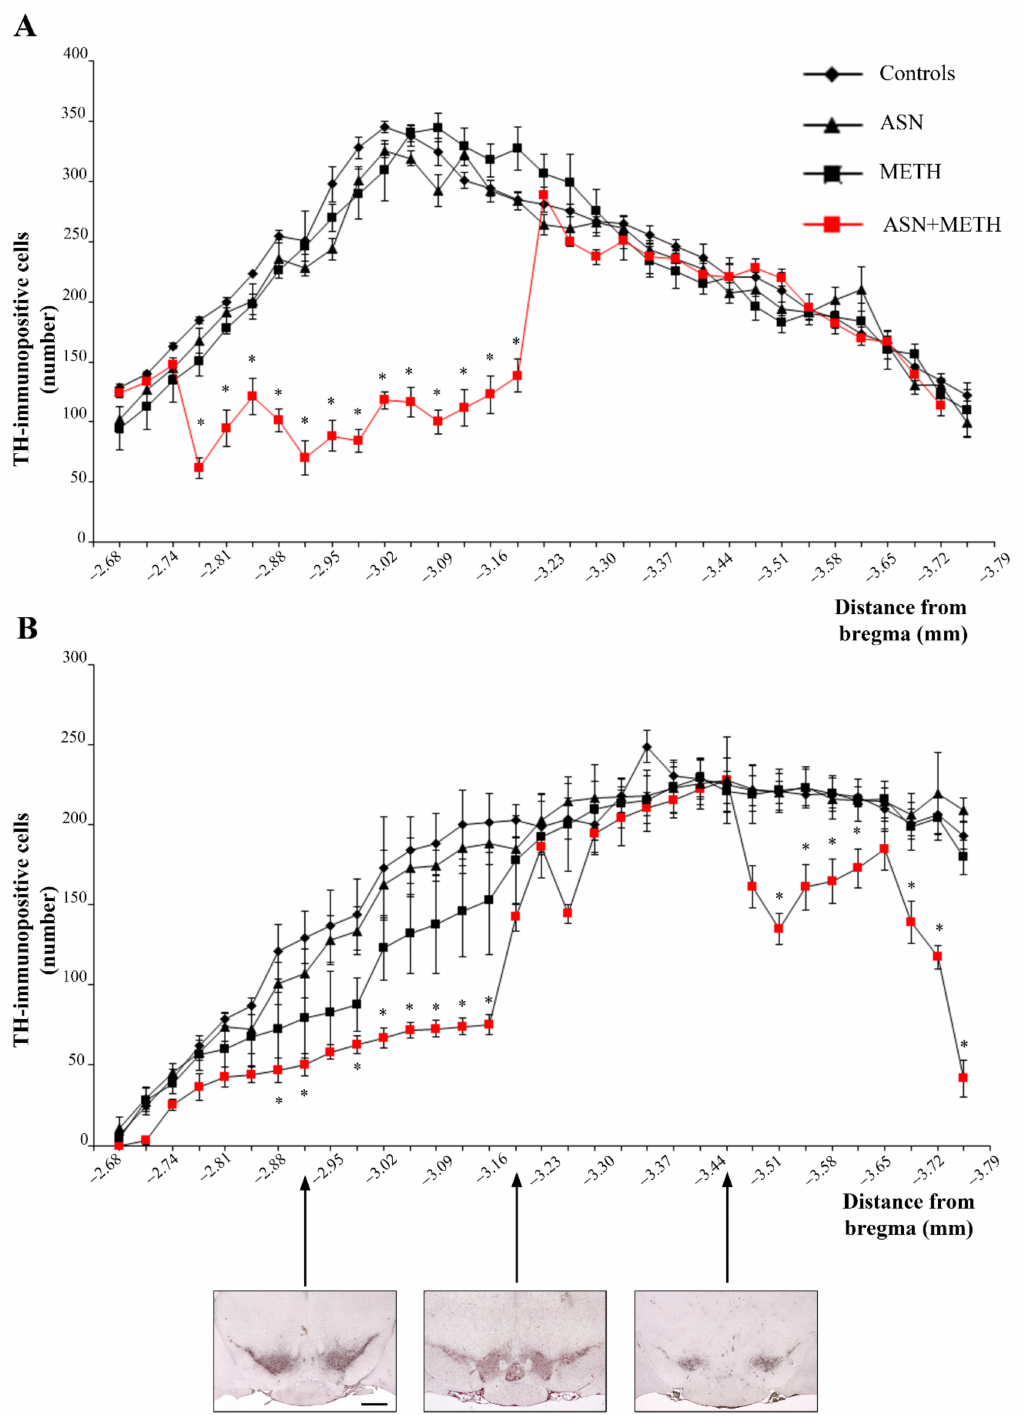
Figure 7. Counts of TH-immunopositive cells within SNpc and VTA following ASN and METH administration. Graphs report the number of TH immunopositive cell bodies which were counted within each slice in ( A ) SNpc and ( B ) VTA. Counts are carried out across the whole rostro-caudal extent of both nuclei. Representative images from three mesencephalic levels are reported in the bottom part of the figure. Each level is identified through its stereotaxic coordinates. * p < 0.05 compared with Controls. Scale bar = 480 µ